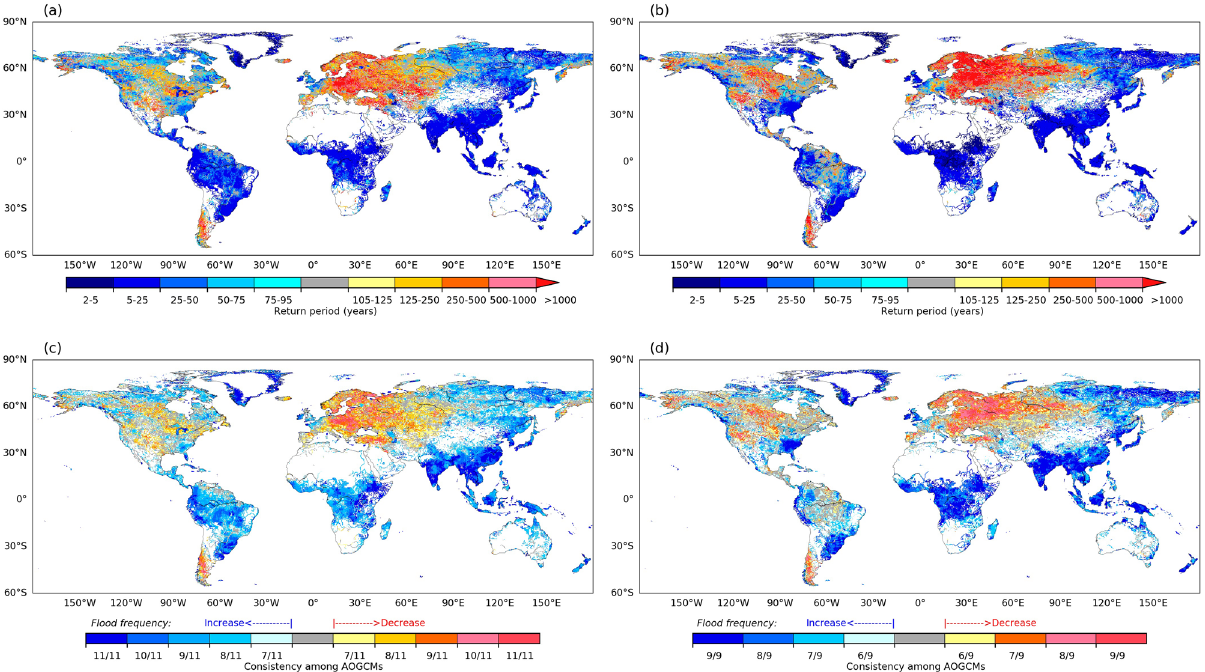
Figure 1. Projected change in flood frequency. Multi-model median return period (years) in future (2071– 2100) for discharge corresponding to a 100-year flood in the past (1971–2000), and for ( a ) CMIP5 and (b) CMIP6 under the RCP8.5 and ssp585 (SSP5-RCP8.5) scenarios, respectively, and model consistency for ( c ) CMIP5 and (d) CMIP6. Grid cells with a mean annual discharge of a retrospective simulation for 1971–2000 of < 0.05 mm −1 day are screened out (see “Methods”). This figure was created using python